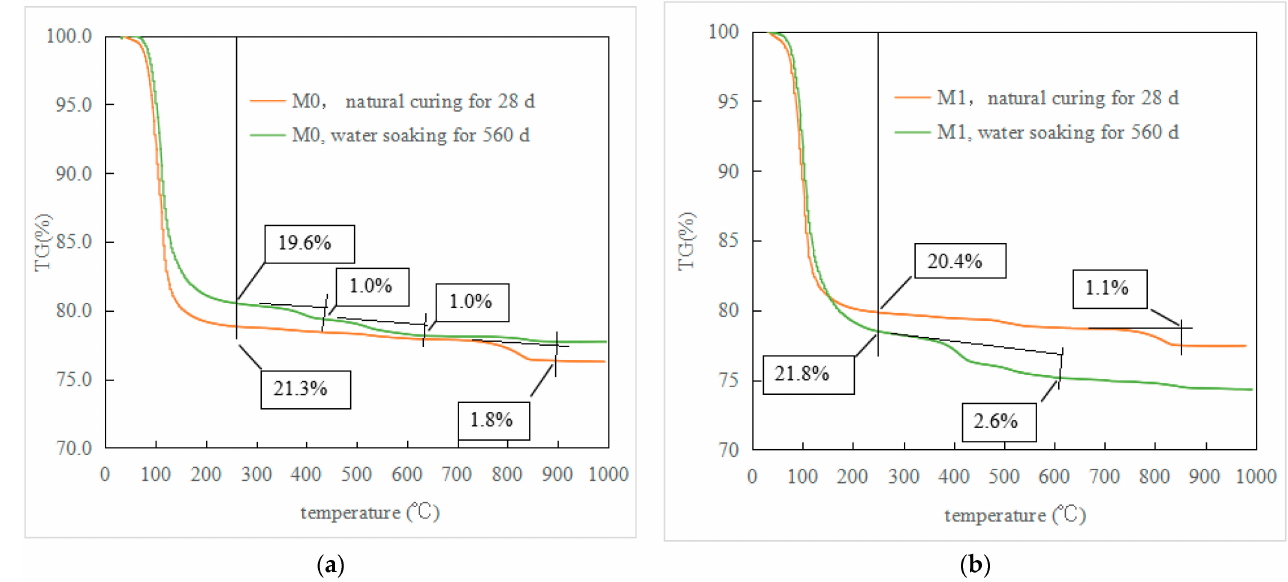
Figure 5. TG curves of the MKPC samples. ( a ) M0, ( b )